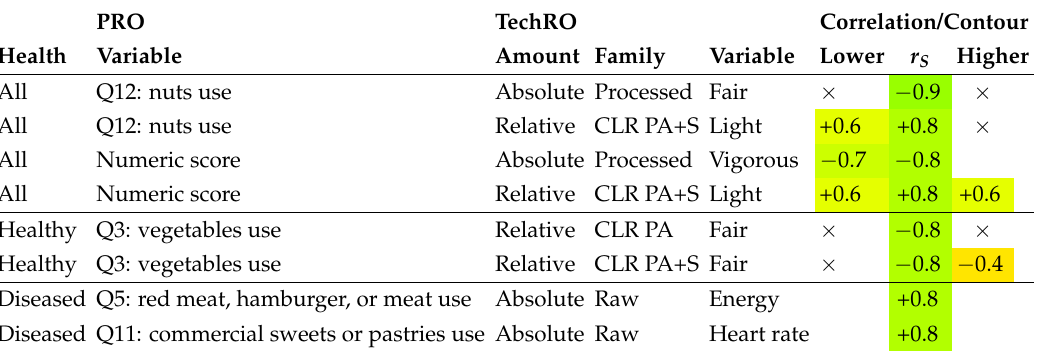
Table 10. Summary of found strong and significant Spearman rank correlations ( r S PROs of Mediterranean nutrition (PREDIMED scale) and TechROs (Fitbit